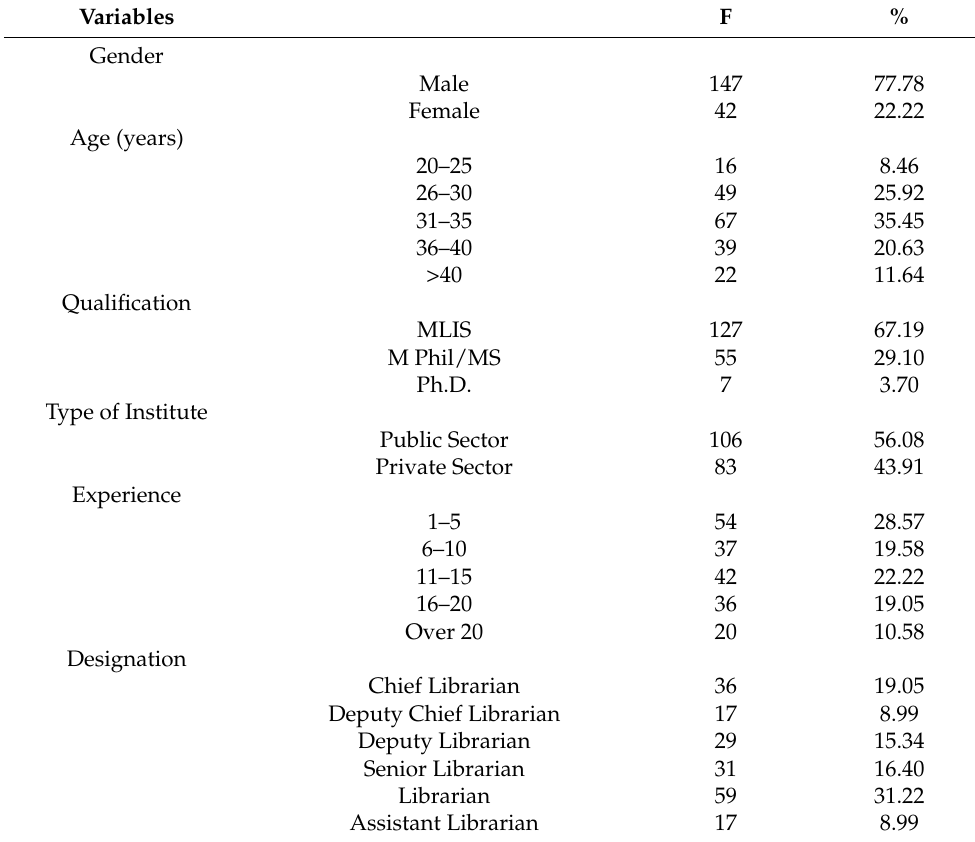
Table 1. Descriptive analysis of demographic information of respondents (N =